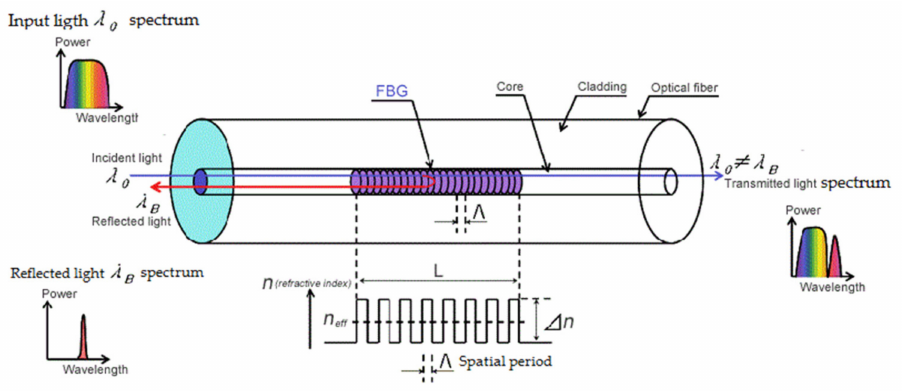
Figure 1. Principle of measurement of the FBG